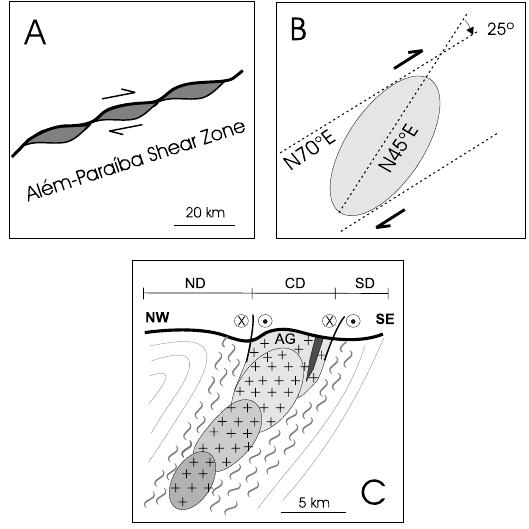
Fig. 3 – Simplified sketch of the Além-Paraíba Shear Zone (APSZ): A) Model of displacement along the APSZ and creation of transten- sional spaces; B) Geometric relation between the APSZ and probable orientation of magmatic foliation during the emplacement of the Ar- rozal Granite; C) Schematic NW–SE geological section cross-cutting the Arrozal